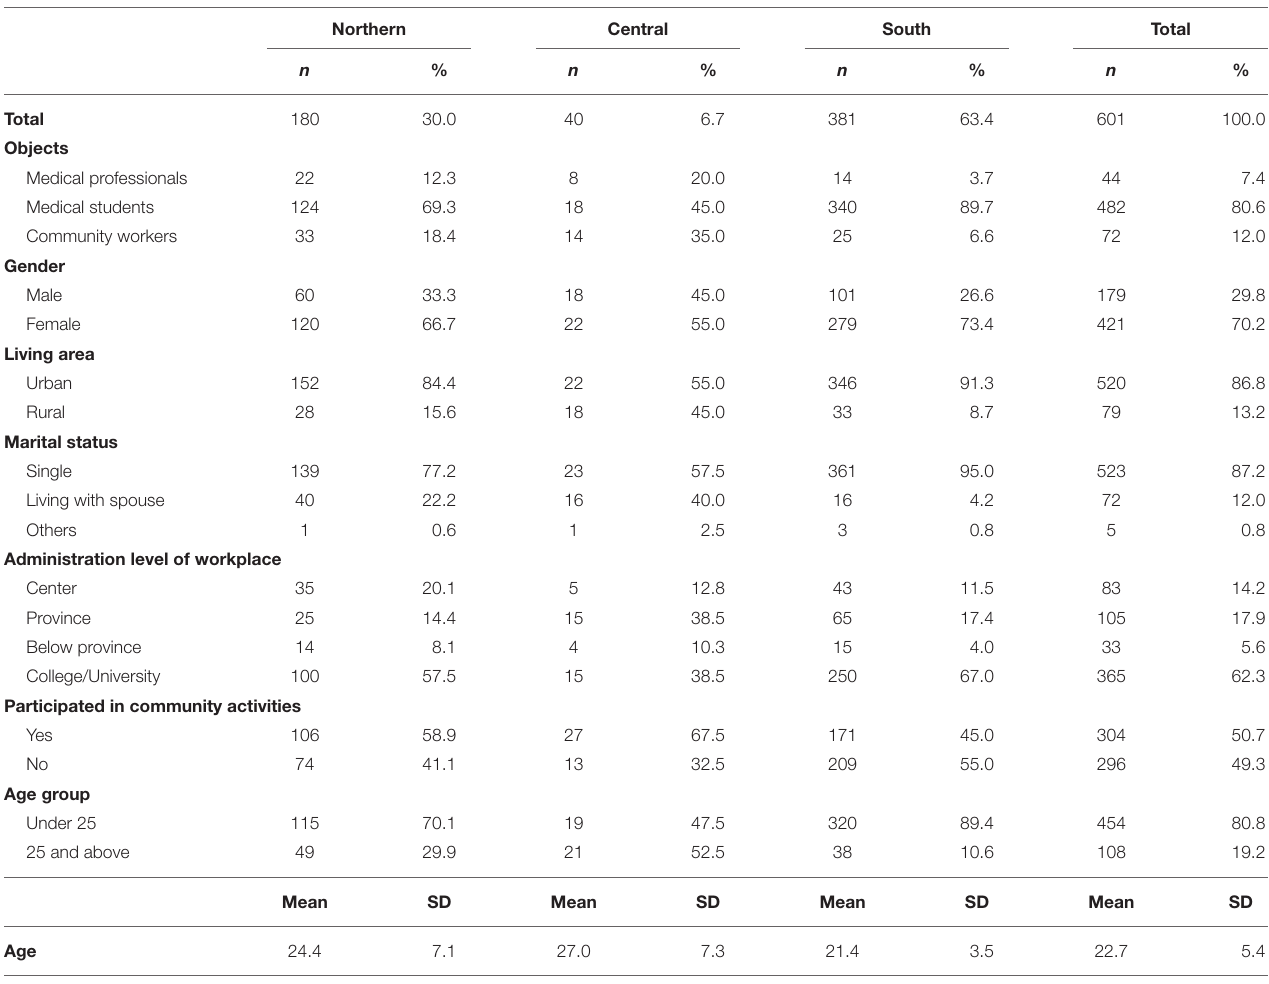
TABLE 1 | Socio-economic characteristics of respondents. Northern Central South